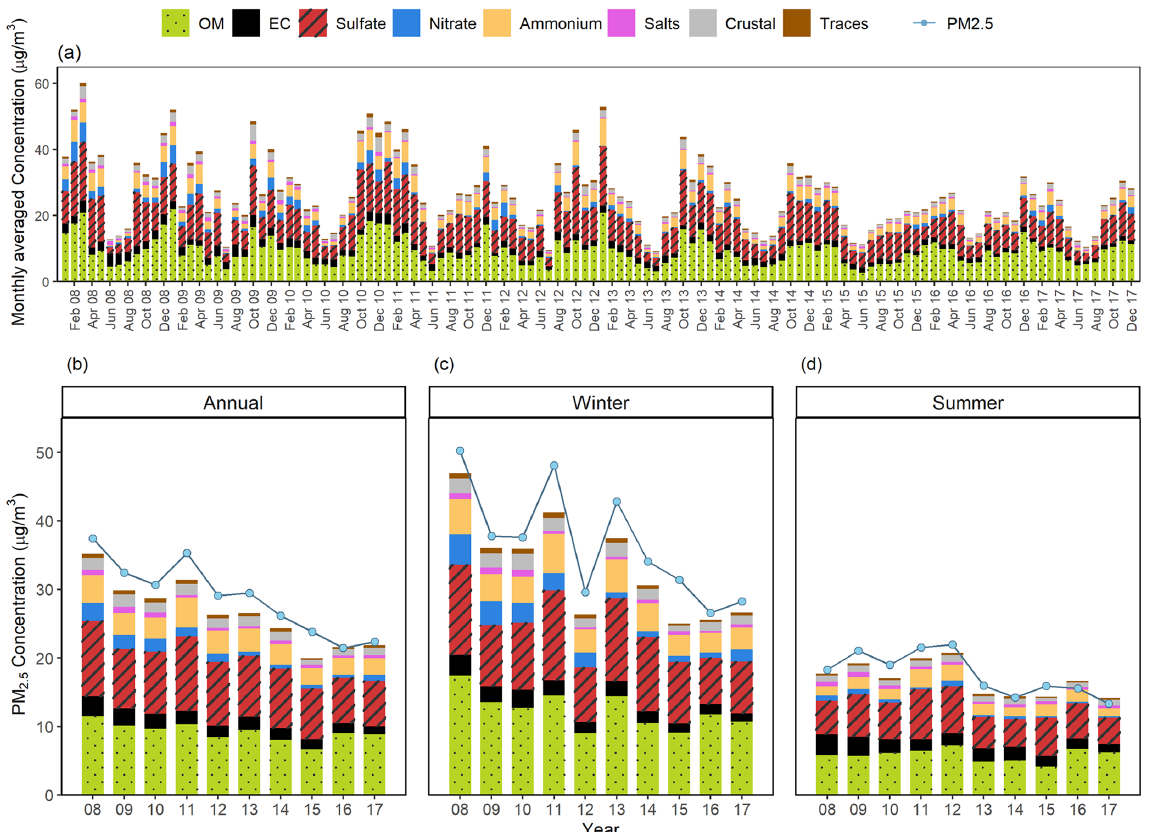
Figure 2. Time series of PM 2 . 5 chemical composition from 2008 to 2017 in the form of (a) monthly averages, (b) annual average, (c) winter seasonal averages, and (d) summer seasonal averages. In the legends, “Salts” includes Na + and Cl − ; “Crustal” represents crustal materials, computed to be 1 . 89 · Al + 2 . 14 · Si + 1 . 4 · Ca + 1 . 43 · Fe; and “Tracers” includes elements other than Na, Cl, S, K, Al, Si, Ca, and Fe. OM refers to organic matter and is computed as 1 . 4 ·